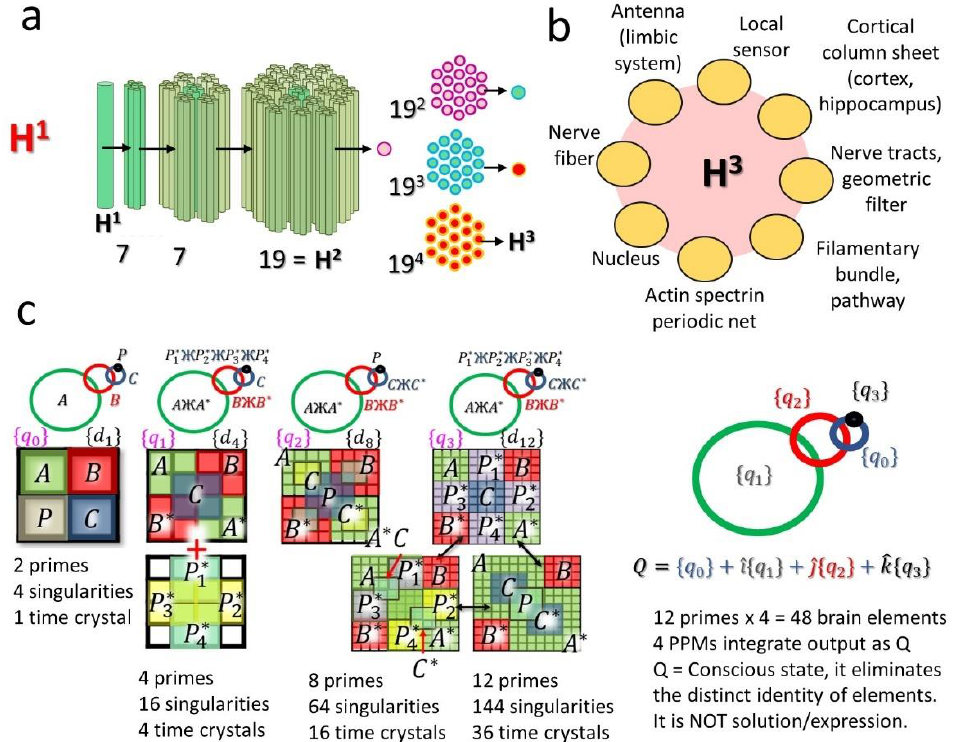
Figure 3. ( a ) The fundamental device for the hardware construction of the brain is made of a typical α -helix inspired fourth circuit element, namely Hinductor and it is depicted with a singular rod, named H1. H1 is in reality a 3rd generation of helix, for example, α -helix forms protein and protein spiral forms microtubule and microtubule spiral forms axonal core part, thus neuron is H1, a 3 rd generation Hinductor, H1. hexagonal close packing of 19 is the H2 generation device and when H2 forms H3, it is a 2D sheet of cortical column like structures. This 2D sheet is the basic decision making device in our model brain [41]. ( b ) The examples of structures found in the brain which resembles structures that of the third generation H device. ( c ). The brain’s information structure is the linguistic quaternion made of four queries (Who, at what condition, what and how) for all four types of tensors. Here 2 × 2, 4 × 4, 8 × 8 and 12 × 12 tensors represent linguistic quaternion in di ff erent ways; to deliver an output Q, i.e., the conscious state shown at the extreme right.